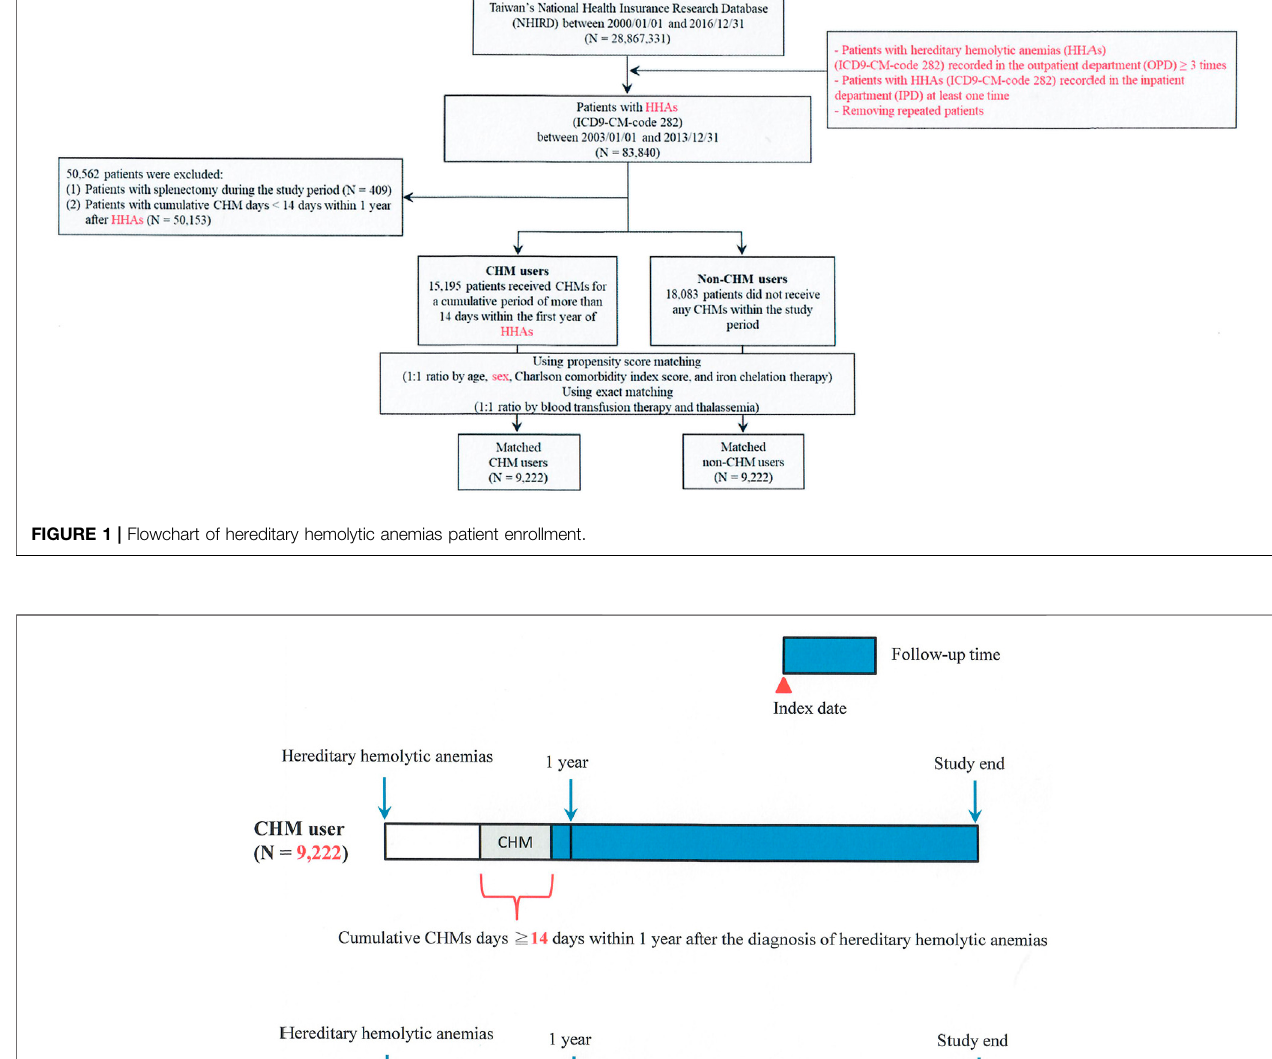
Frontiers in Pharmacology |